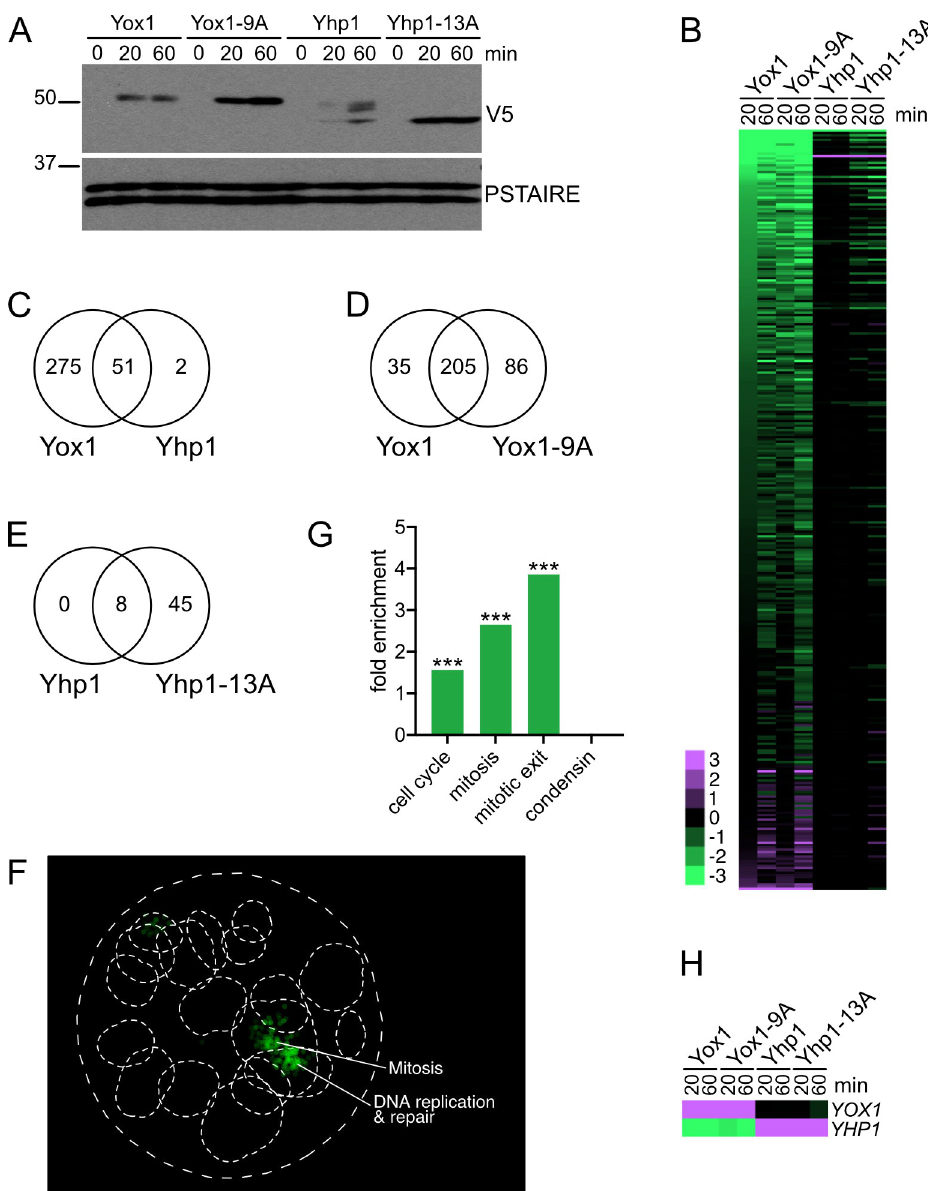
Fig 2. Identification of Yhp1/Yox1-regulated genes. Strains with the Z3EV promoter integrated upstream of YHP1 , yhp1-13A , YOX1 , or yox1-9A were treated with estradiol to induce TF overexpression for 20 or 60 minutes. (A) Western blot showing expression of the indicated proteins following 20 or 60 minutes of estradiol induction. All proteins were detected with antibodies that recognize a C-terminal 3V5 tag on Yhp1 or Yox1. PSTAIRE is shown as a loading control. (B) Heat map of all genes significantly changed in expression (at least 1.5-fold) after 20- or 60-minute induction of any of the four tested TF proteins. Genes are sorted by the background subtracted log fold change value following Yox1 induction after 20 minutes. List of genes and primary data is included in S6 Dataset. (C) Overlap of all genes that were significantly changed in any Yox1/Yox1-9A sample and all genes significantly changed in any Yhp1/ Yhp1-13A sample. Overlap was determined to be significant using a hypergeometric test, p = 5.9e -68 . (D) Overlap of all genes significantly changed in Yox1 at 20 or 60 minutes and all genes significantly changed in Yox1-9A at 20 or 60 minutes. Overlap was determined to be significant using a hypergeometric test, p = 6.4e -270 . (E) Overlap of all genes significantly changed in Yhp1 at 20 or 60 minutes and all genes significantly changed in Yhp1-13A at 20 or 60 minutes. Overlap was determined to be significant using a hypergeometric test, p = 5.2e -18 . (F) SAFE analysis of all genes shown in (B). Enriched processes are indicated. (G) Fold enrichment of genes from the indicated groups of cell cycle genes in the list of Yhp1/Yox1-regulated genes from (B), ��� p < 0.0005. For parts (F) and (G) all analyses and statistics are included in S7 Dataset. (H) Zoom in on regulation of YOX1 and YHP1 expression from part (B), highlighting that Yox1 represses YHP1 expression. Scale bar matches (B).